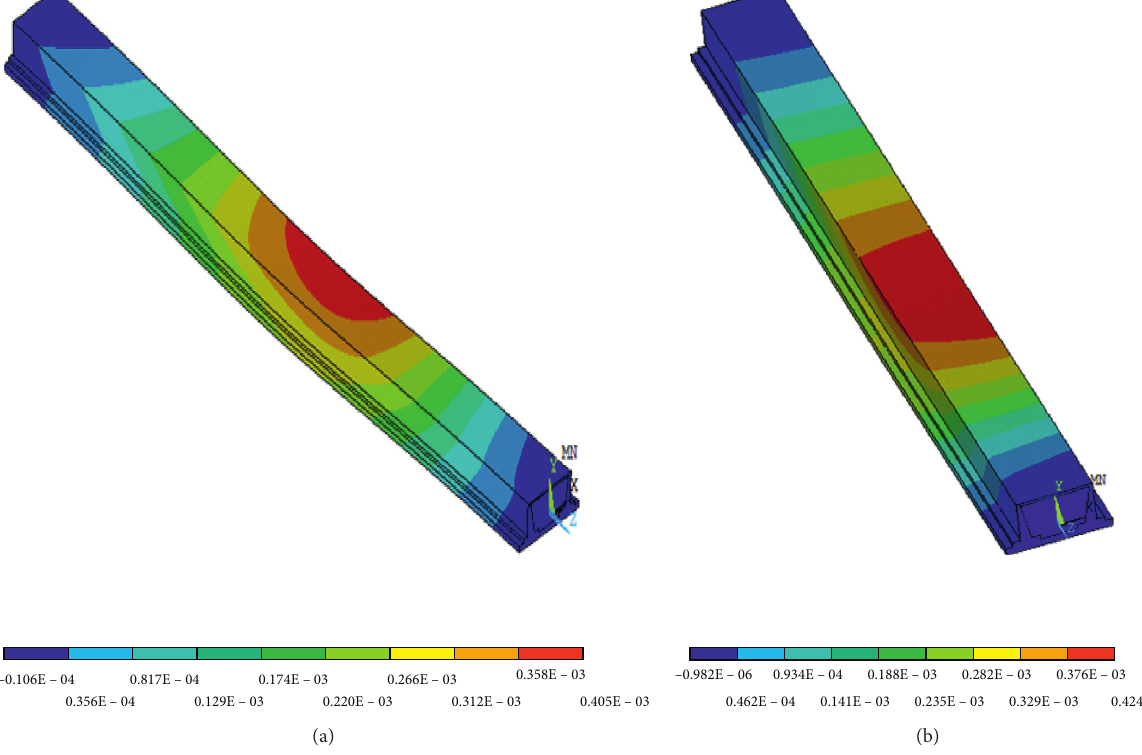
Figure 8: Horizontal displacement. (a) Left-line underpass. (b) Right-line underpass.